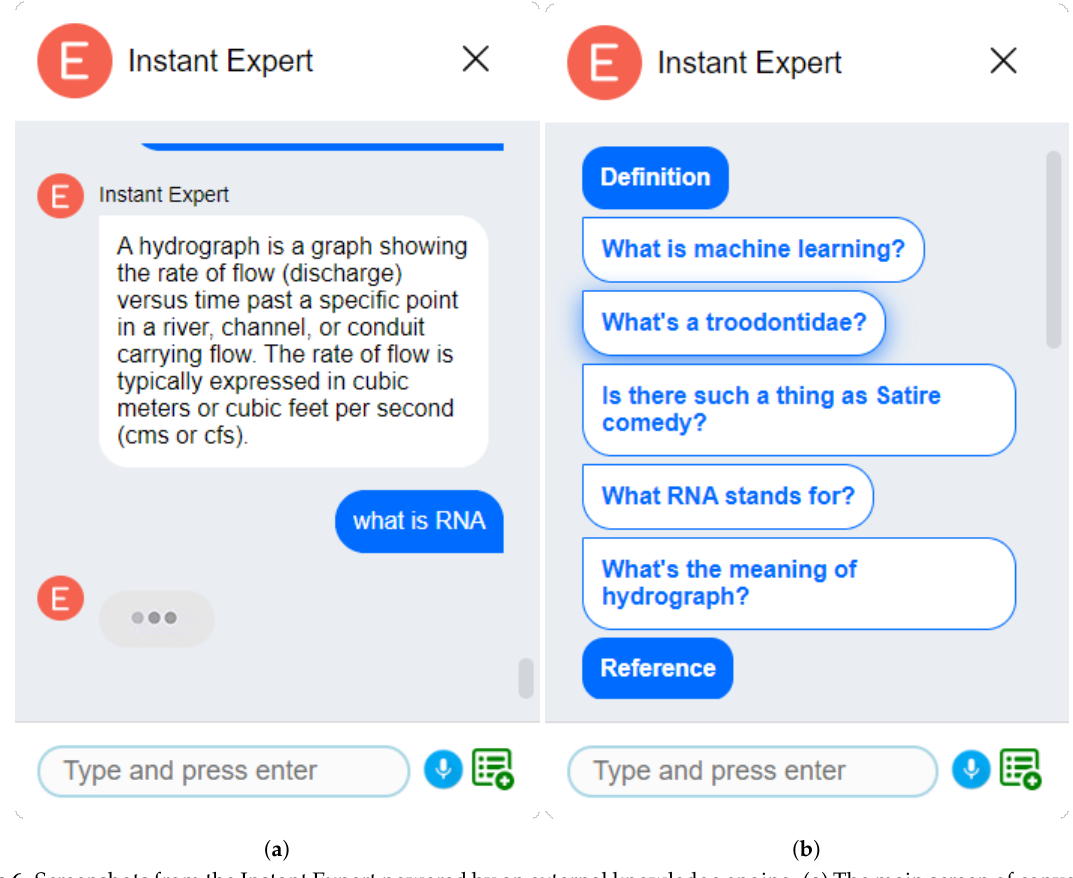
Figure 6. Screenshots from the Instant Expert powered by an external knowledge engine. ( a ) The main screen of conversation